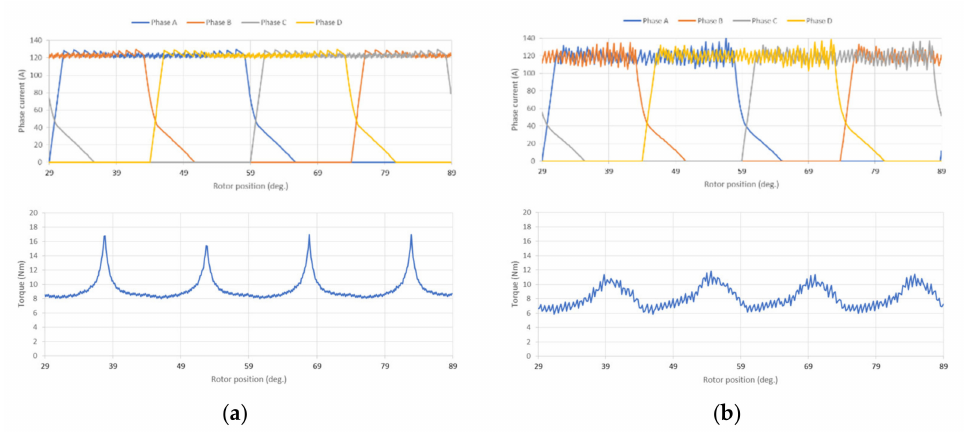
Figure 5. Mesh size of FEA model ( a ) 6/4 SRM; ( b ) 8/6 SRM.